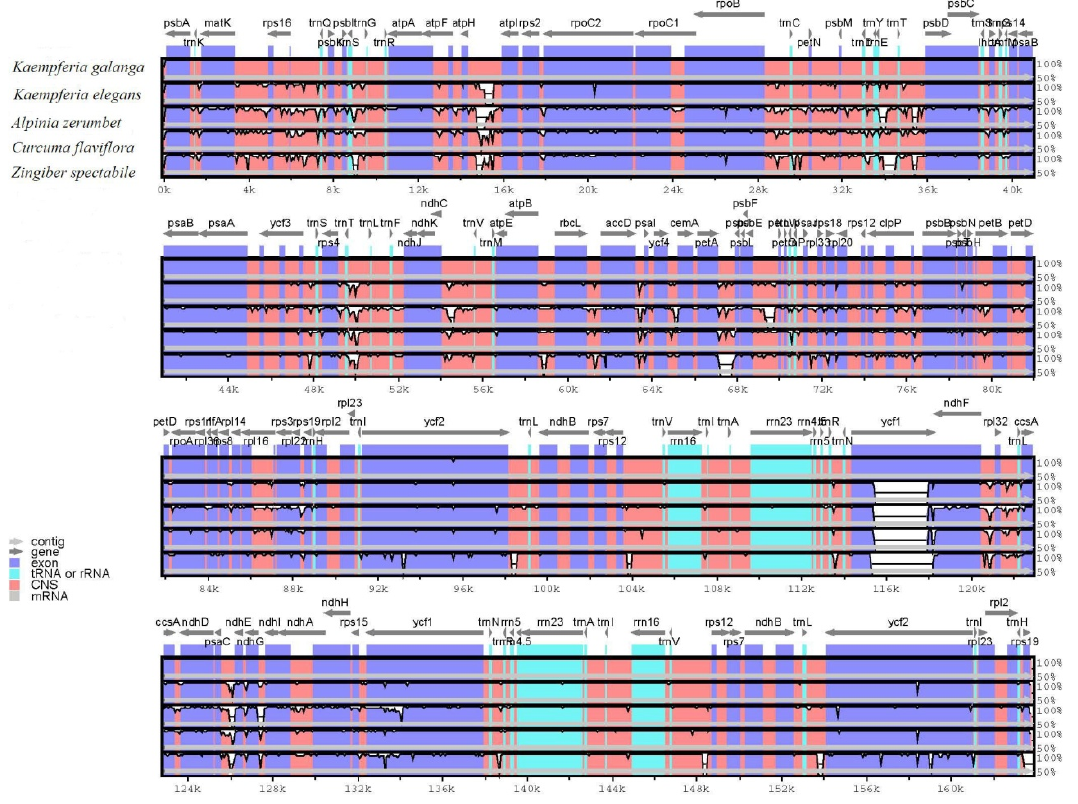
Figure 6. Comparison of five chloroplast genomes, with K. galanga as a reference using mVISTA alignment program. Gray arrows and thick black lines above the alignment indicate gene orientation. Purple bars represent exons, sky-blue bars represent transfer RNA (tRNA) and ribosomal RNA (rRNA), red bars represent non-coding sequences (CNS) and white peaks represent differences of chloroplast genomes. The y -axis represents the identity percentage ranging from 50 to 100%.